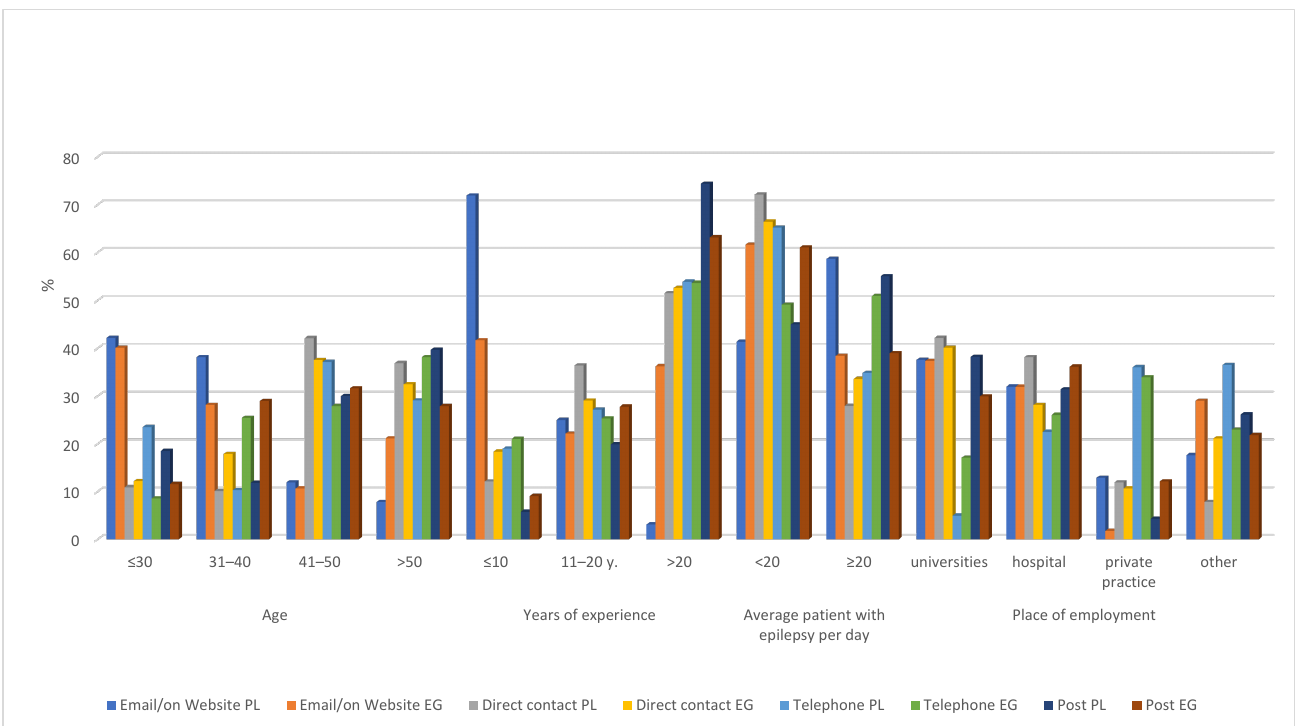
Figure 1 . The most popular communication method preferred by neurologists to send adverse drug reactions (ADRs) to an ADR reporting center.